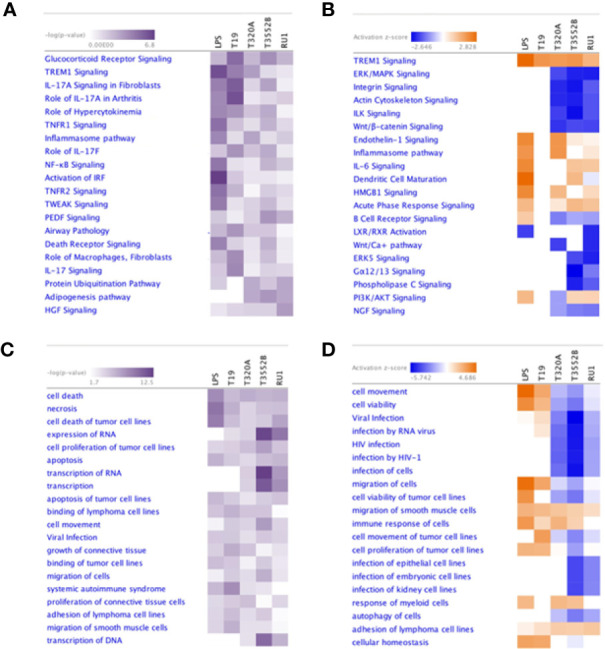
Comparison of the most significantly enriched canonical pathways, diseases and biological functions in primary bovine foot skin fibroblasts challenged with pathogenic and commensal treponemes. Ingenuity pathway analysis identified the most significantly enriched (A) canonical pathways and (C) diseases and biological functions in primary bovine foot skin fibroblasts challenged with T. medium phylogroup (strain T19), T. phagedenis phylogroup (strain T320A), T. pedis (strain T3552BT) and T. ruminis (strain Ru1T). A right-tailed Fisher Exact Test was used to calculate the probability of enrichment compared to the IPA database, denoted as –log(p value) with p ≤0.05 for statistical significance. The most activated (orange) or inhibited (blue) (B) canonical pathways and (D) diseases and biological functions were calculated with an IPA z-score algorithm. The greater the z-score beyond 2 the greater the prediction for activation, whereas the greater the z score below −2 the greater the prediction for inhibition. Unknown or undetermined activity was denoted by gray and white respectively. For simplicity, heatmaps only document the 20 most enriched canonical pathways, diseases and biological functions for each parameter.